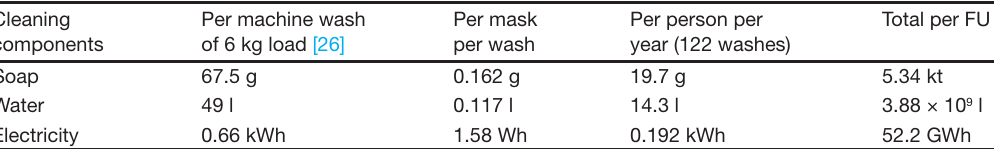
Table A9. Requirements for the machine-washing of face masks for Scenarios 4 and 5. Cleaning components